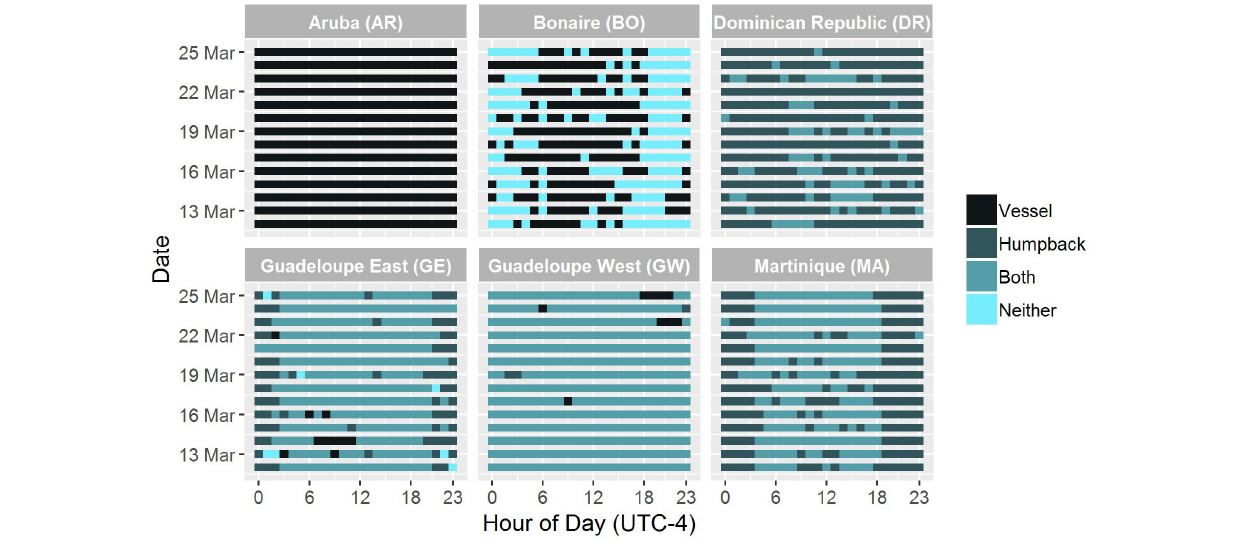
analysis because of the duty-cycled nature of the data. At GE, a diel pattern in the number of vessel passages was observed with vessel noise receding late at night between the hours of 21:00 and 3:00 UTC-4 ( Figure 5 ). The greatest density of vessels passages occurred during daylight